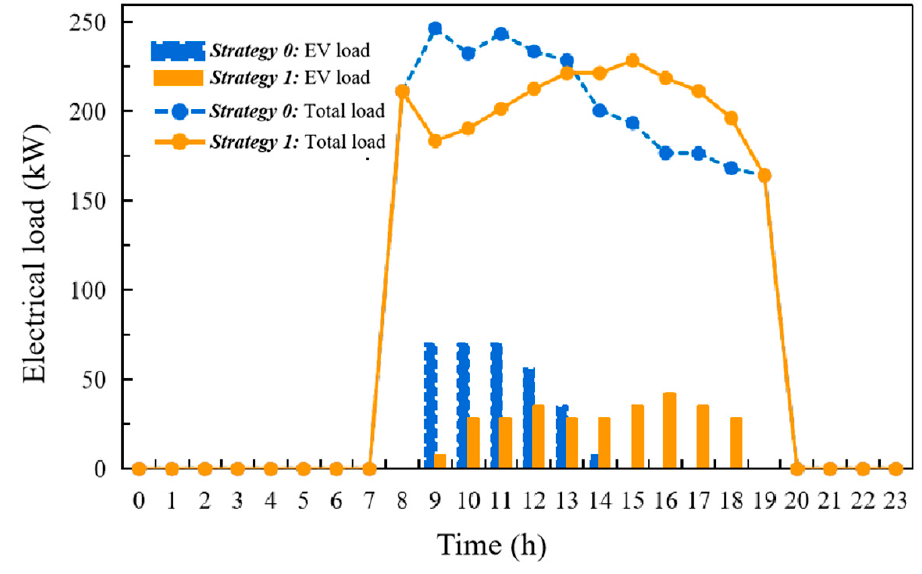
Figure 8. Load comparison between Strategy 0 and Strategy 1.